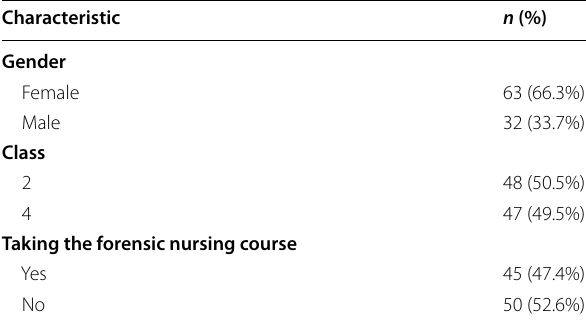
Table 2 Nursing students’ gender, class, and status of taking the forensic nursing course ( n 95) =